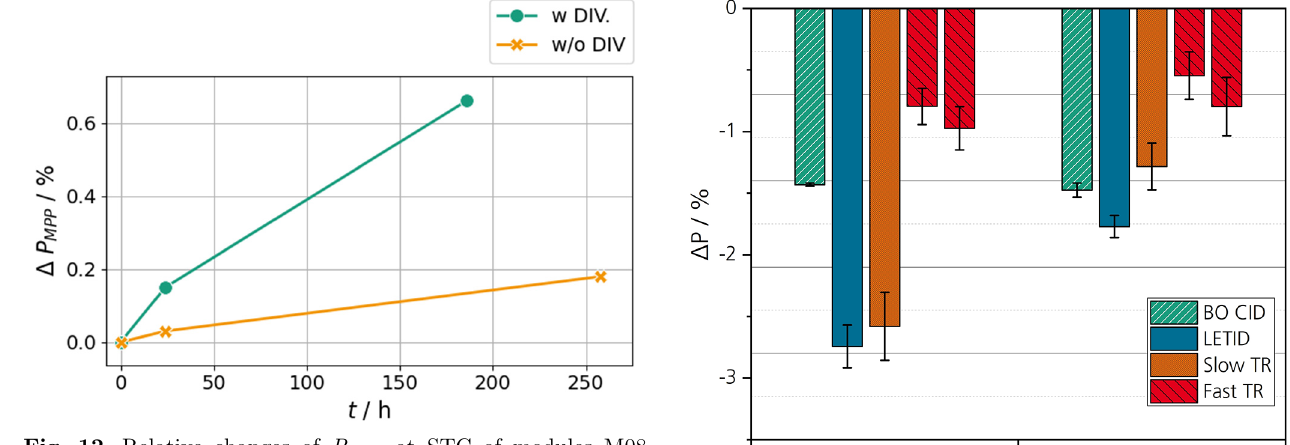
Fig. 12. Relative changes of P MPP at STC of modules M08 (w DIV) and M09 (w/o DIV) during temporary recovery at 25 ° C and I SC (cid:3) I